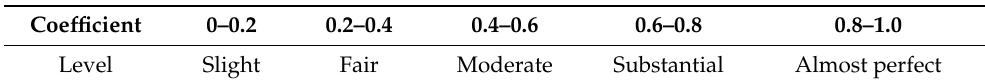
Table 2. Kappa coefficient